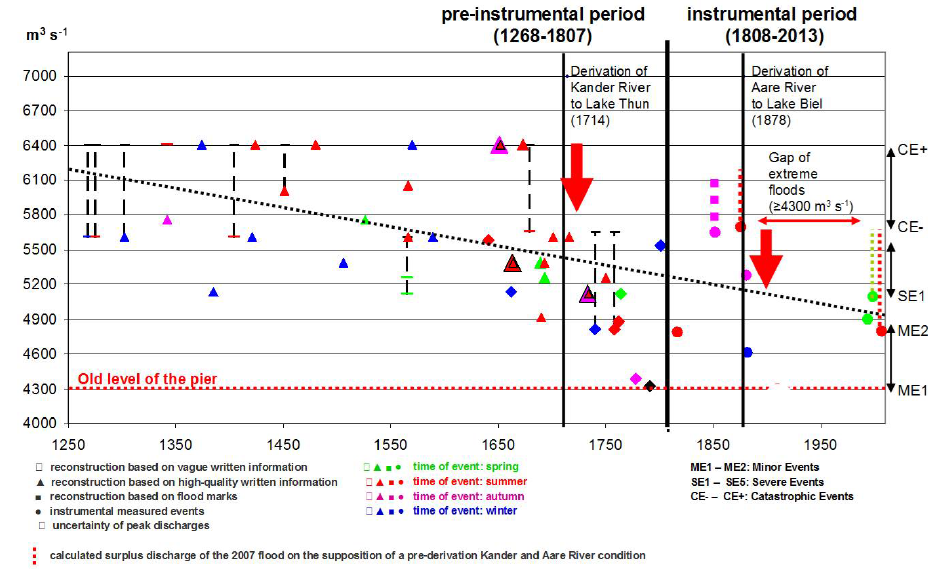
Figure 9. River Rhine discharges in Basel for the period 1250–2010 (Wetter et al., 2011).